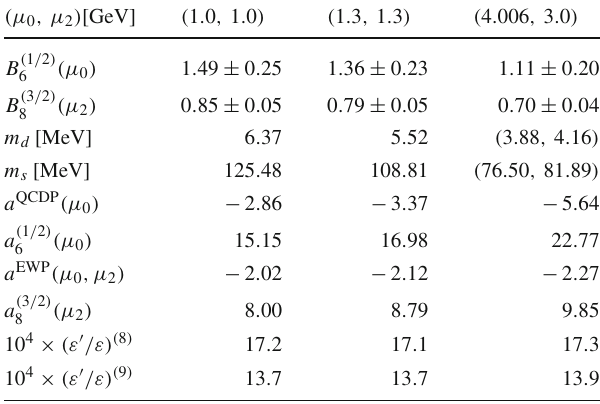
Table 1 Coefficients entering the semi-analytic formula (20), when the amplitudes A 0 and A 2 are evaluated at the scales μ 0 and μ 2 , respec- tively,fordifferentchoicesof (μ 0 ,μ 2 ) .Thecentralvaluesfor (ε (cid:2) /ε) ( 8 , 9 ) with these approximate formulas are given in the last two